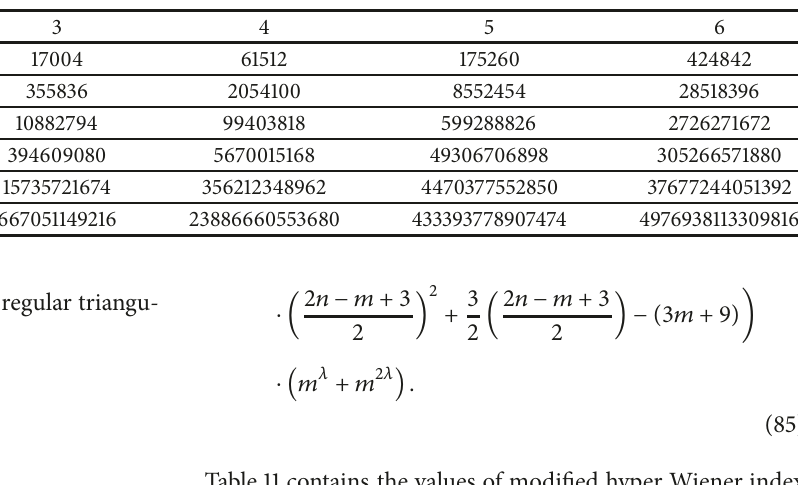
Table 11: Modified hyper Wiener index of 𝑅𝑇𝑆𝐿 .